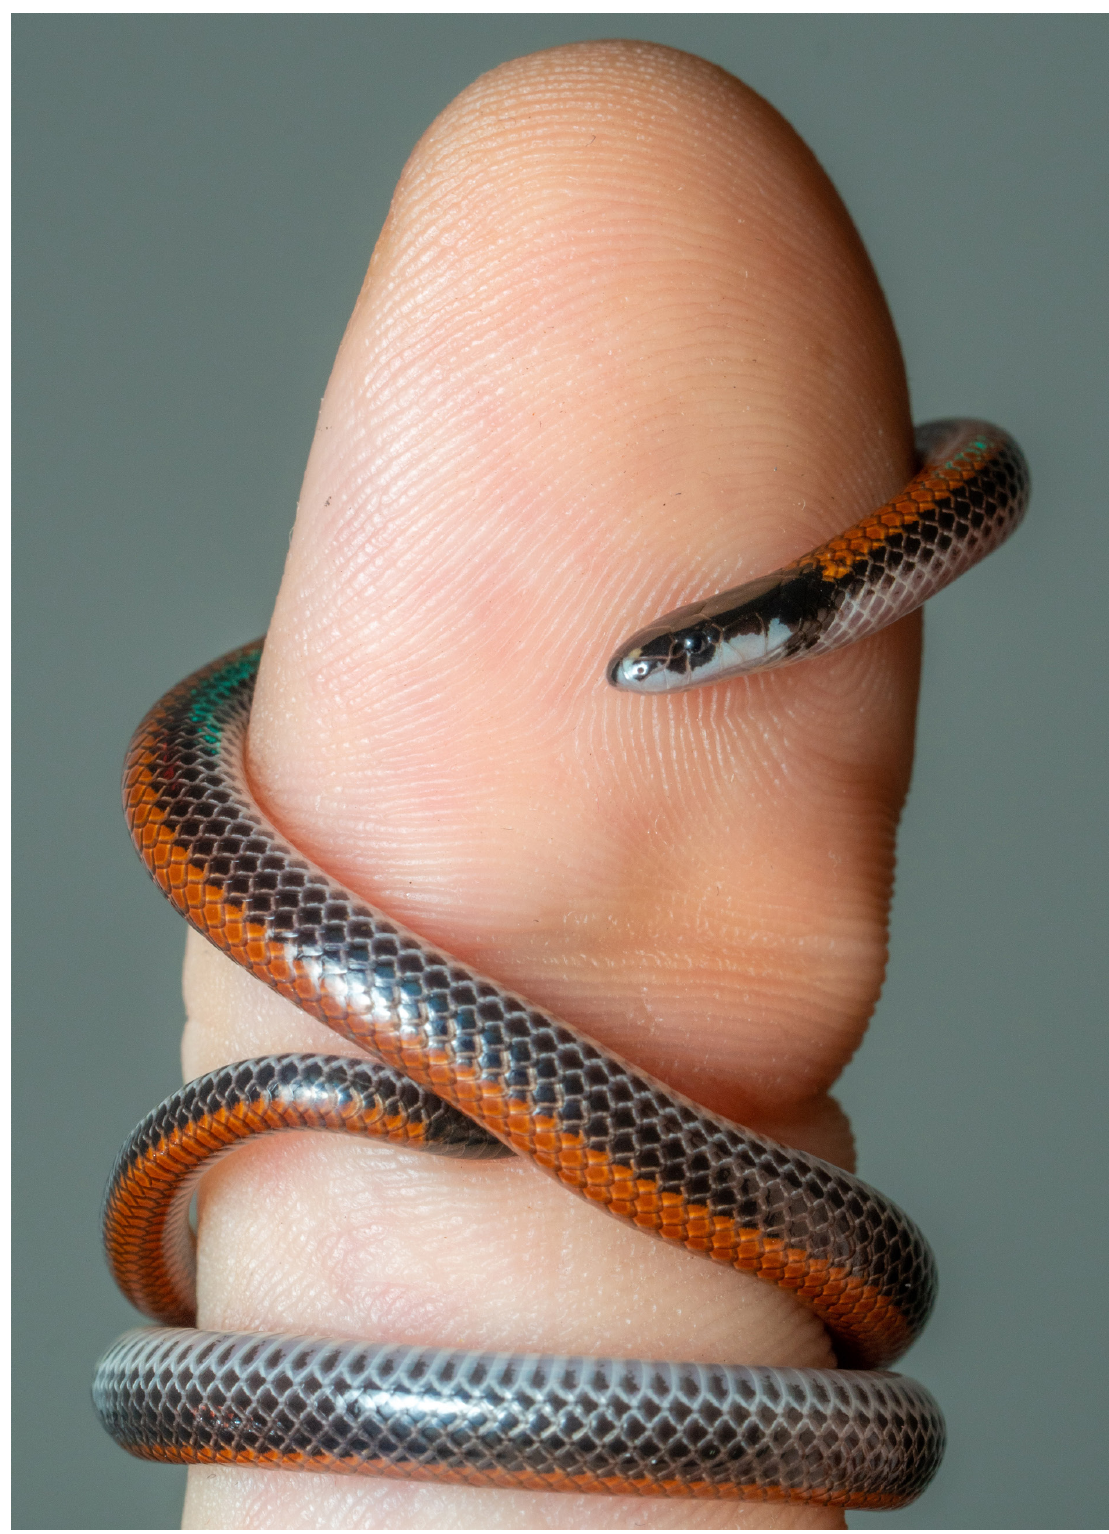
Fig. 12. Apostolepis dimidiata (Jan, 1862), putative sister-species of Apostolepis albicollaris Lema, 2002, adult specimen from Estação Ecológica Santa Bárbara, São Paulo, Brazil. Photograph credit: Giordano